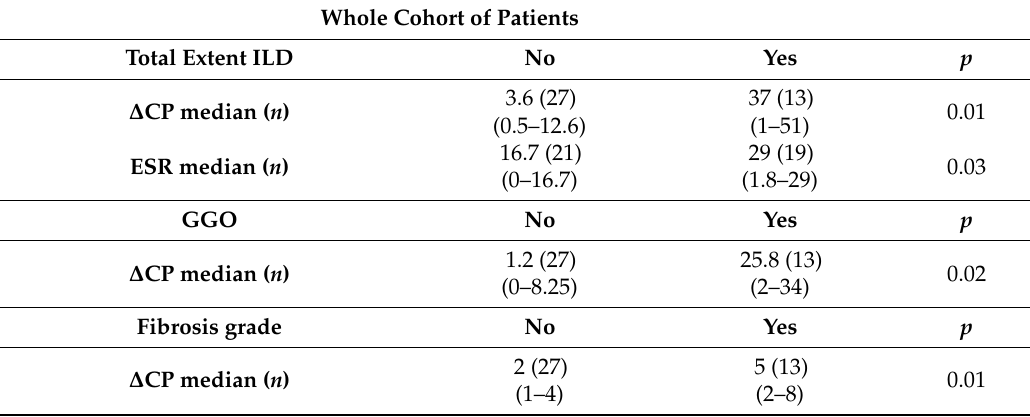
Figure 1. Correlation in diffuse cutaneous Systemic Sclerosis. Legend: ESSG: European Scleroderma Study Group Index; GGO: Ground Glass Opacity; SPAP: Systolic Pulmonary Artery Pressure TE-ILD: Total Extent of Interstitial Lung Disease. Spearman’s Test ( A ) r = 0.45, p = 0.02; ( B ) r = 0.5, p = 0.009; ( C ) r = 0.4 p = 0.04; ( D ) r = 0.46, p = 0.02. Table 2. Significant differences in semi-quantitative assessment of ILD according to the items included in ESSG score.